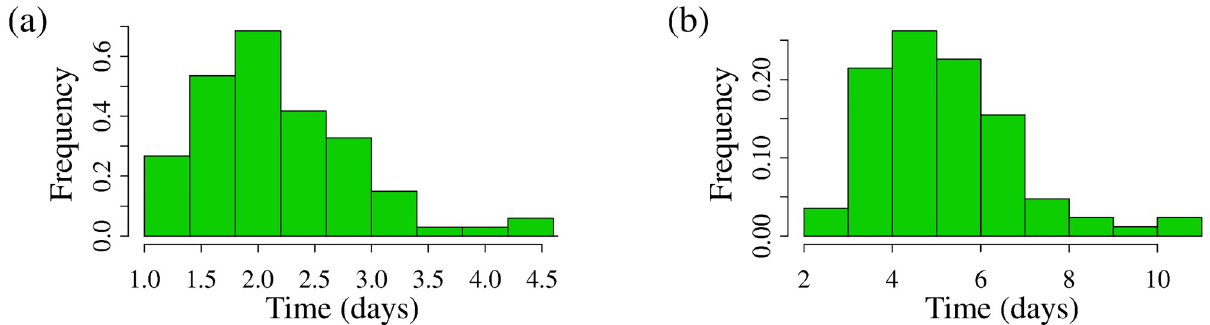
Fig 8. Model-predicted average frequency of recrudescence events. Histograms of model-predicted average time between successful latent cell activations, across ATI study population (see Description of data ) assuming (a) a Weibull-distributed detection delay and (b) a fixed detection delay. The predicted population-average is a successful activation every (a) 2.2 days and (b) 5.2